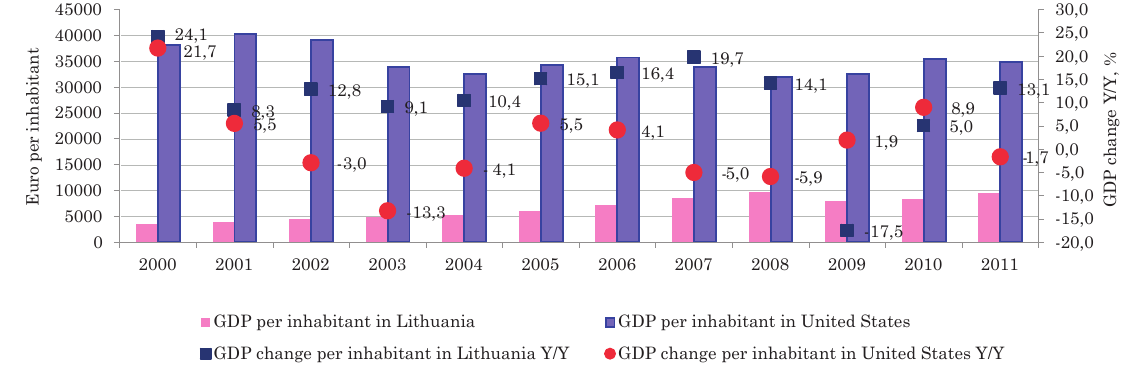
Figure 1. GDP dynamics in Lithuania and United States in 2000–2011 ( GDP ...,